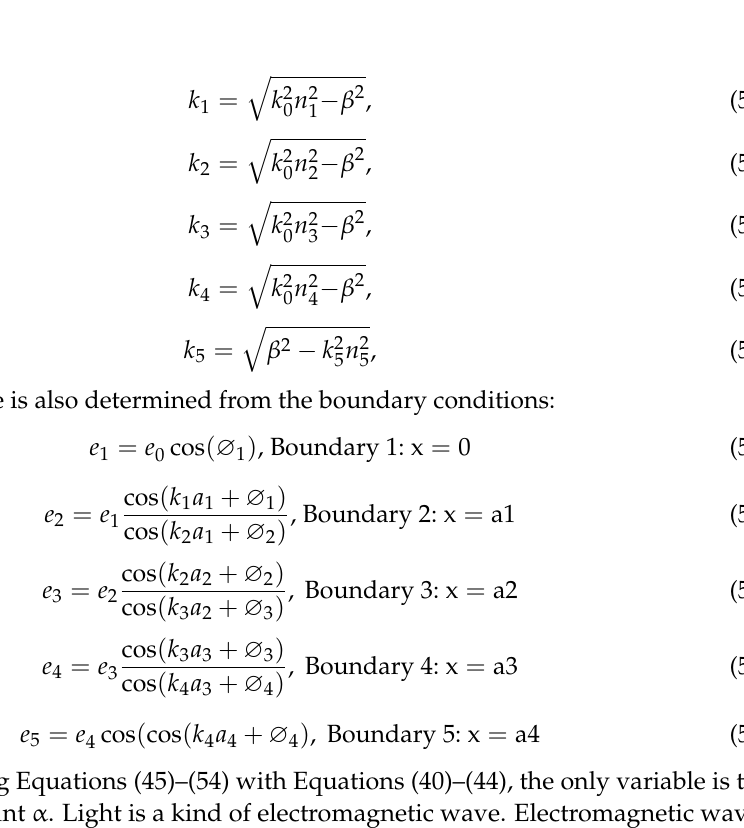
( b ) ( c ) Figure 10. ( a ) Deformed optical waveguide viewed from the side. ( b ) Scattering inside the optical waveguide due to waveguide deformation. ( c ) Optical waveguide. 3.4. Geometric Optics Approximation Section 3.3 considered the light propagation in a waveguide to be an electromagnetic field. Figure 11 shows the boundary condition between the PDMS layers may be used to mathematically represent the solution to Maxwell’s equation. This explanation of wave propagation is called the physical optics approach, and it is appropriate for waveguides with layers as thin as a few microns. The wave-optical analysis for thin waveguides is considerably difficult when compared to thick waveguides. As a result, light propagating through a thick waveguide should be considered a ray. This method, known as geometric